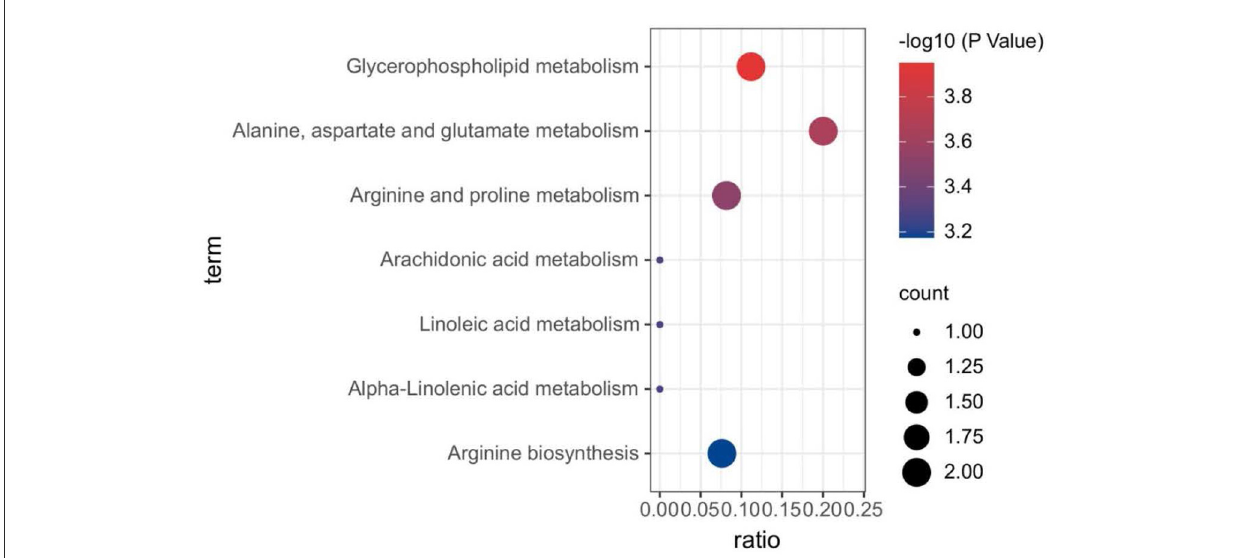
FIGURE2 Biological pathways associated with PM 2.5 exposure. The color gradient indicates the significance of the pathway ranked by P -value (blue: higher P -values and red: lower P -values), and circle size indicates the pathway impact score (the larger circle the higher impact score). PM 2.5 , PM with particle diameter < 2.5 µ m.